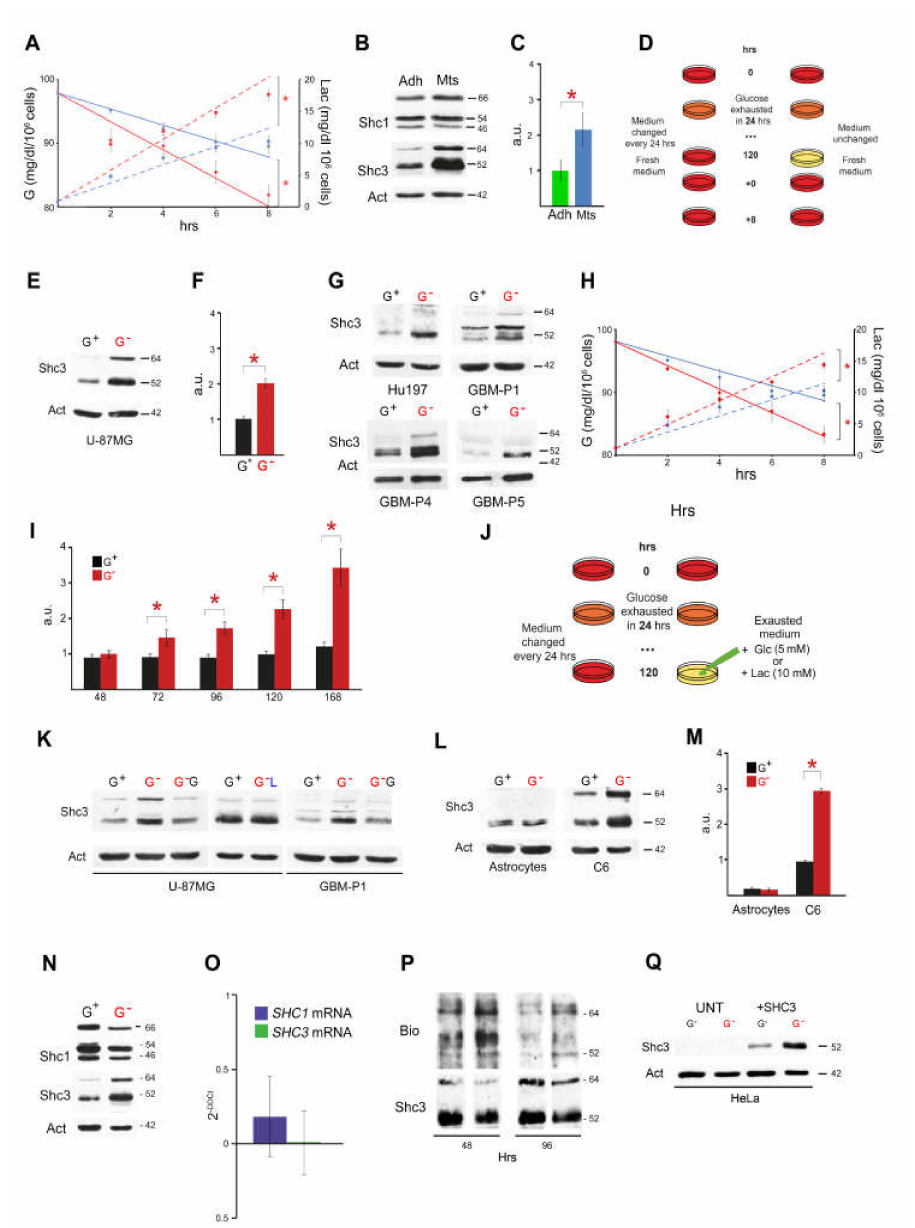
Figure 1. Rate of glucose uptake and SHC3 level increase in glioblastoma cells maintained in exhausted medium. ( A ) Rates of glucose consumption (left axis of ordinates) and lactate production (right axis of ordinates) in stable human glioblastoma cell line U-87 MG growing as MTS or in adherence. Cells growing as MTS (red) have elevated level of SHC3 and show an enhanced uptake of glucose and increased lactate production compared to adherent cells (blue). Here and in the following figures, linear regression of the data was used to outline the di ff erences in glucose metabolism and lactate secretion between treatments without any implication for the true kinetic of the biochemical process. Data are means ± SD (at least n = 3 experiments, * = P < 0.05). ( B ) Western blot using protein lysates from U-87 MG growing in adherence (Adh) or as floating spheroid (MTS). Proteins indicated on the left were demonstrated after reaction with the appropriate antibodies, on the right molecular weights in kDa. ( C ) Densitometry analysis of di ff erences in SHC3 levels in experiments similar to that shown in B. Data are means ± SD (n > 3 experiments; *: P < 0.05). ( D ) Schematic of the culture conditions for glioblastoma cells growing in adherence that enhance SHC3 levels and glucose uptake. ( E ) Western blot using protein lysates from stable human glioblastoma cell lines U-87 MG, cells maintained as indicated in D; G + medium changed daily, G − (red) medium unchanged for 5 days. Both p52SHC3 and